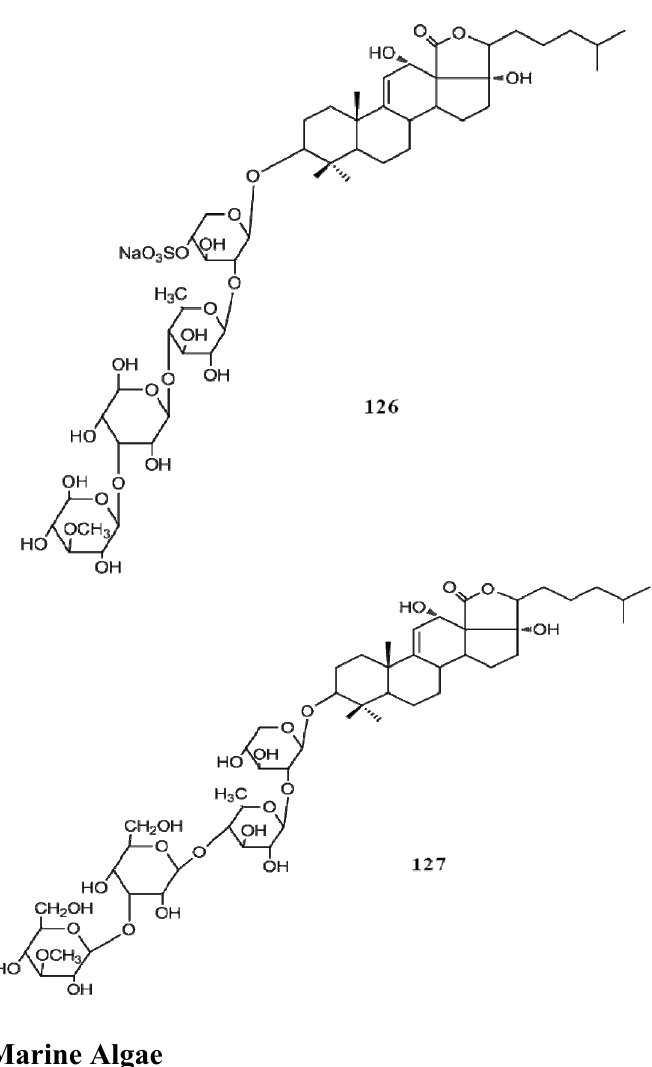
Figure 17. Triterpenoid glycosides echinoside A and ds-echinoside A from sea